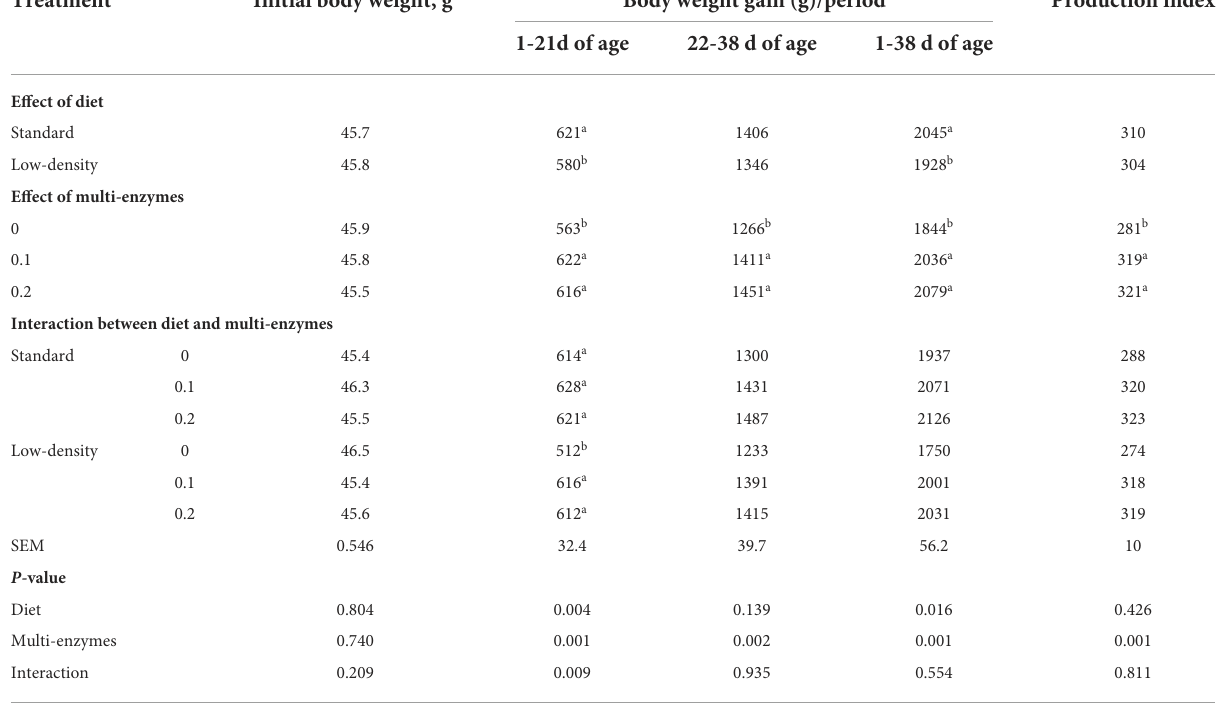
TABLE 2 Growth performance of broiler chickens fed standard and low-density diets supplemented with different concentrations of multi-enzymes from 1 to 38 days of age.